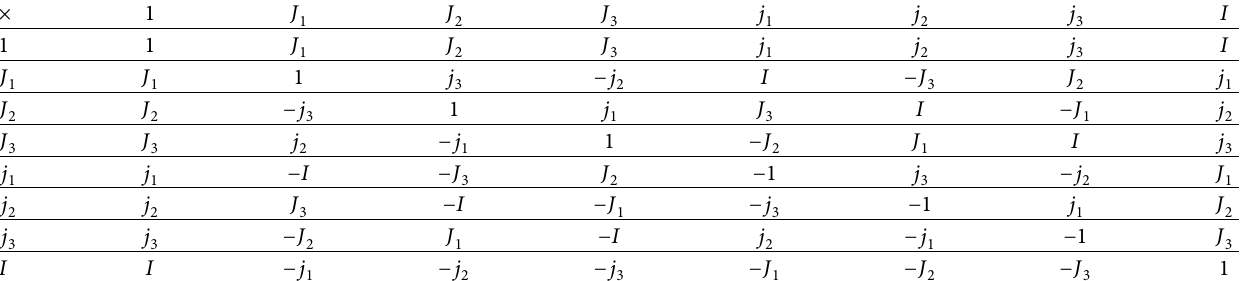
Table 1: Split octonion